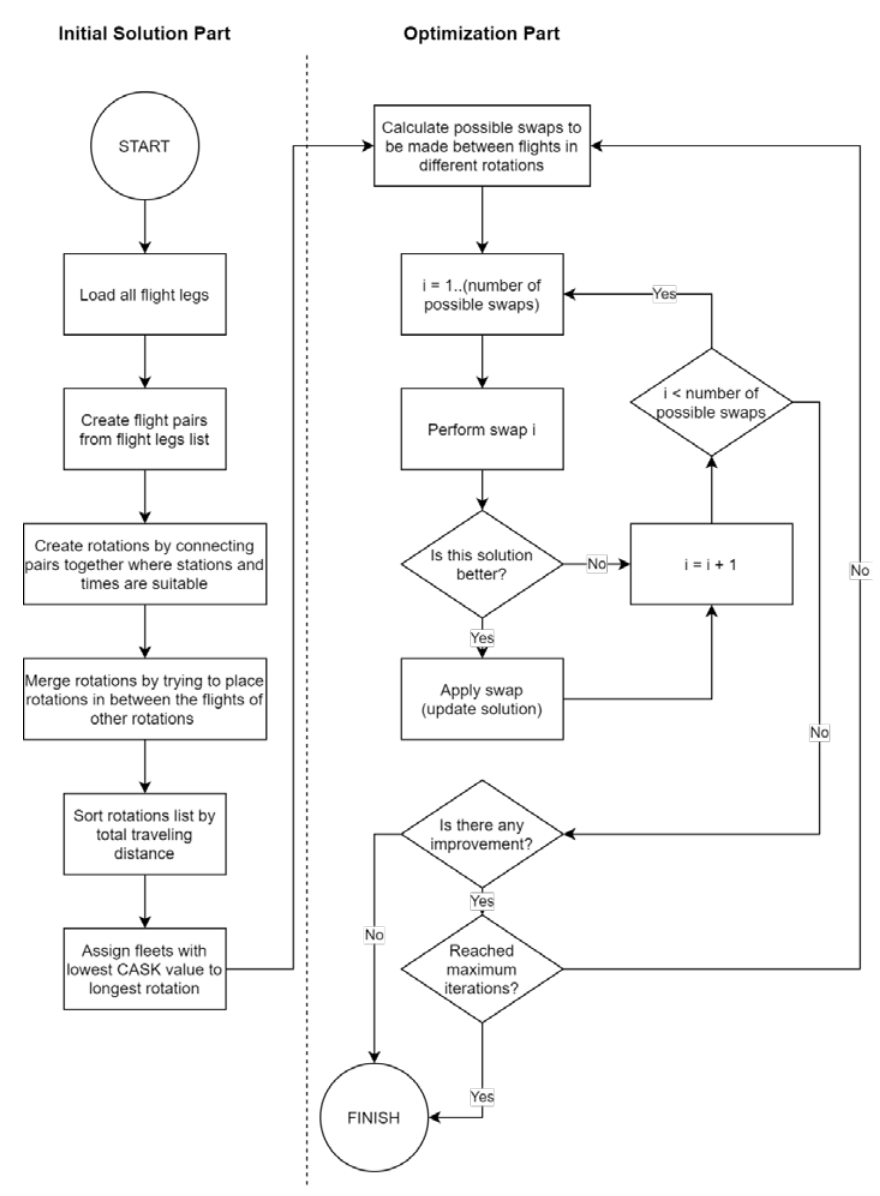
Figure 1. Flowchart of the proposed two-phase algorithm.